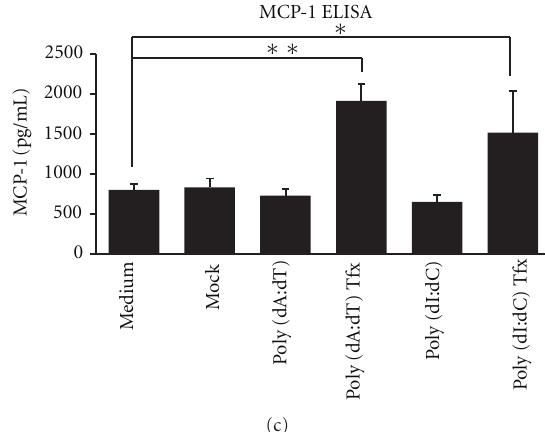
Figure 2: Transcription of cytokine and chemokine mRNA was induced by synthetic double-stranded DNA (dsDNA). (a) Extracellular DNA stimulation had no e ff ect on inflammatory cytokines and chemokines, such as tumor necrosis factor-alpha (TNF- α ), interleukin-6 (IL-6), monocyte chemoattractant protein-1 (MCP-1), and cytokine-induced neutrophil chemoattractant 1 (CINC-1). In contrast, intracellular dsDNA (at 10 μ g/mL) had stimulatory e ff ects on their expression, including the expression of their transcriptional factors nuclear factor- kappa B (NF- κ B) and reticuloendotheliosis viral oncogene homolog B (RelB) (b). Release of MCP-1 was also confirmed by ELISA (c). PSCs: pancreatic stellate cells, TFx: + transfection reagent lipofectamine. ∗ P < 0 . 05, ∗∗ P < 0 .